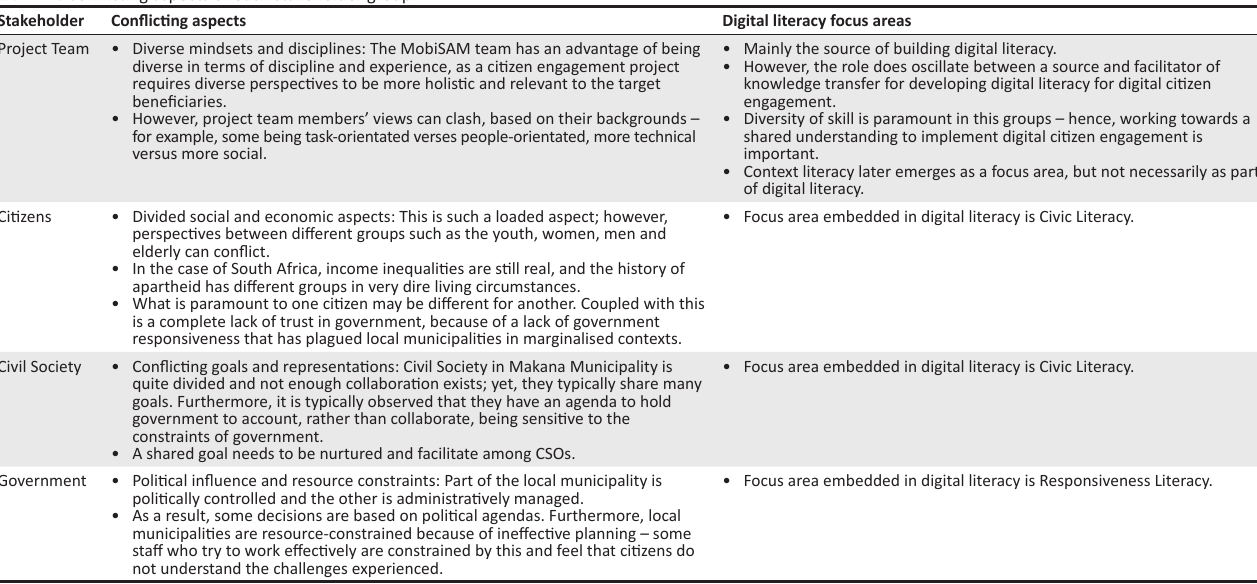
TABLE 1: Conflicting aspects of each stakeholder group.